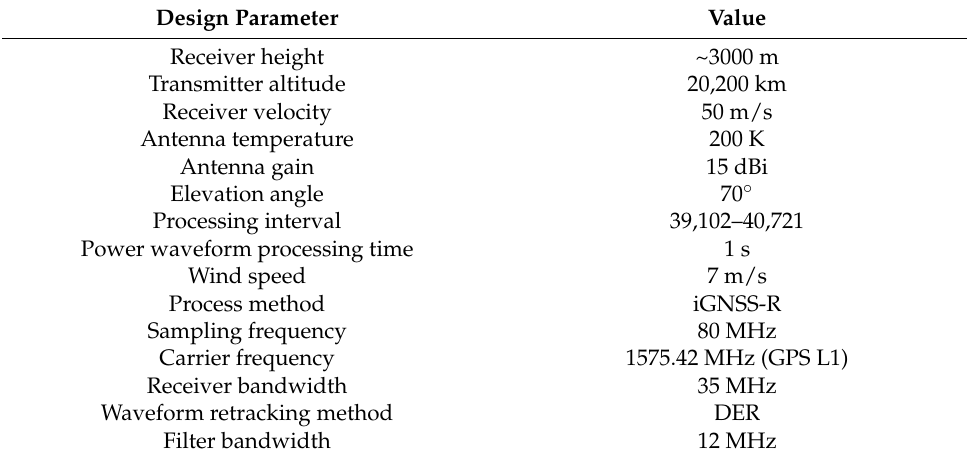
Table 1. Air-based simulation parameters that are consistent with those for the experiment described in Section 2.